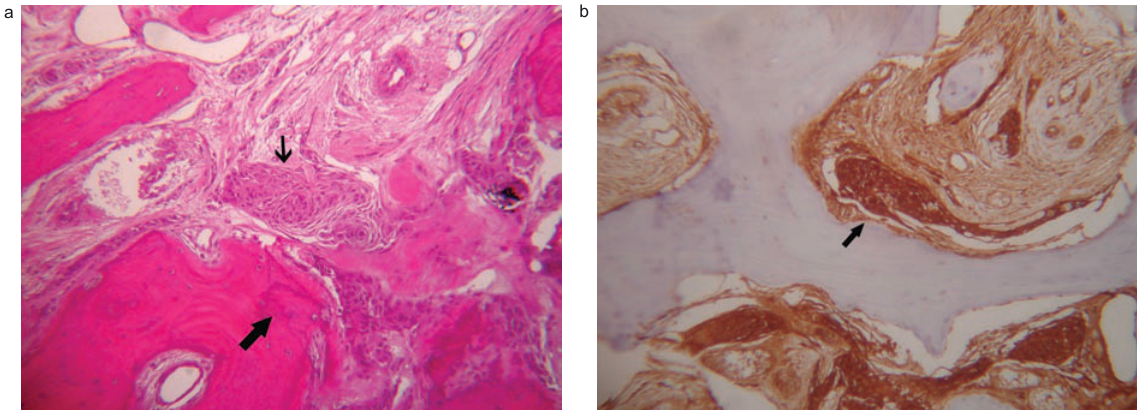
Figure 2. a. Photomicrograph. Abnormal lamellar pattern indicative of osteogenesis imperfecta (large arrow). Note the infiltration of meningioma clusters between the bone trabecula (small arrow). H&E*200. b. Photomicrograph. Positive immunohistochemical vimentin stain for meningioma